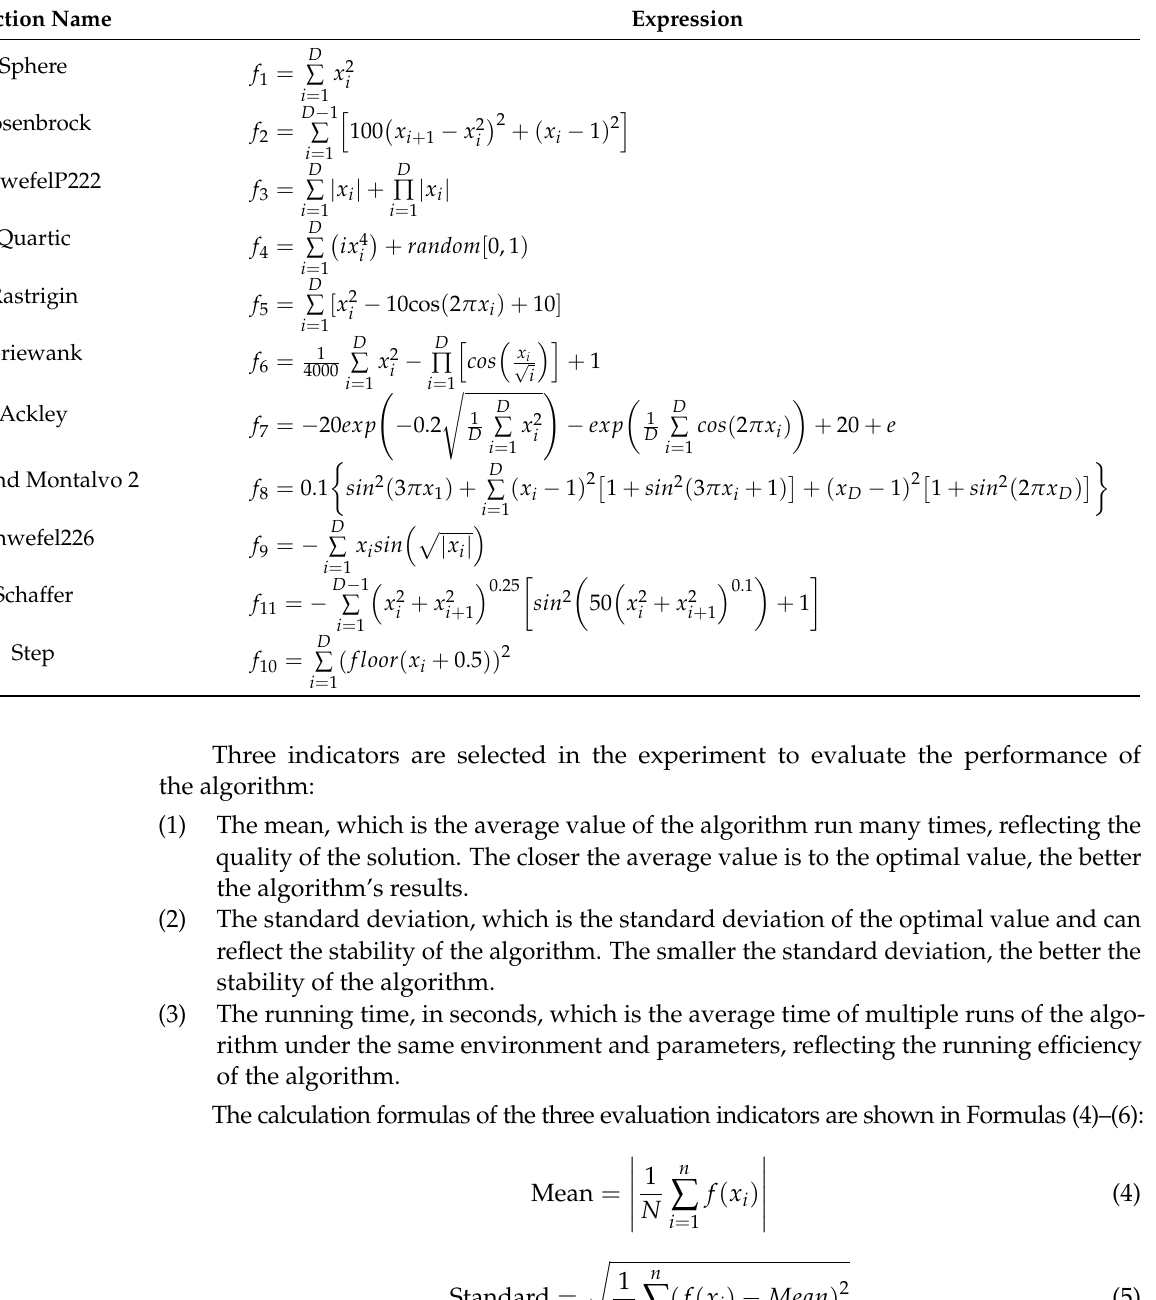
Table 2. Expressions of benchmark test function; this table is a supplement to Table